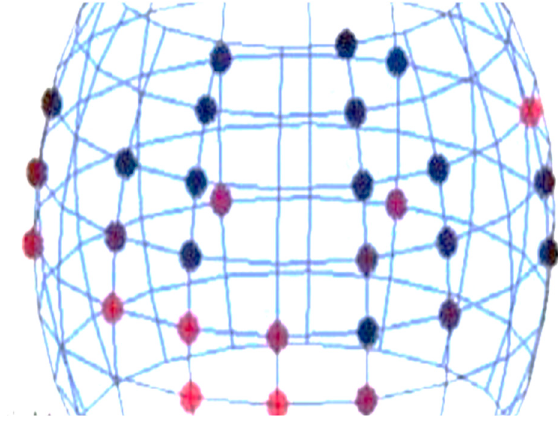
Figure 7. Electrode placement for FECG.